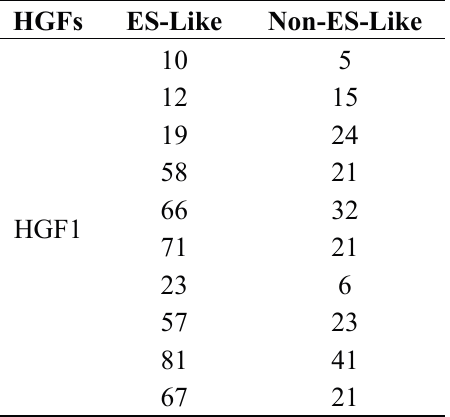
Table 1. Colony number obtained from human gingival fibroblasts (HGFs). Number of colonies per 1 × 10 5 cells after cell reprogramming with episomal vectors. These data are obtained from 16 independent induction experiments using HGFs from three